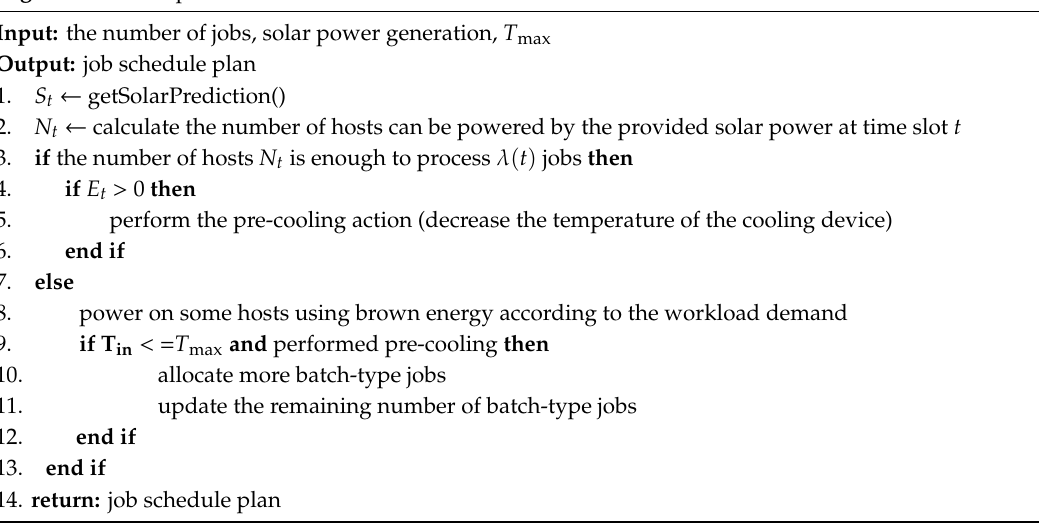
Algorithm 1: The process of TM